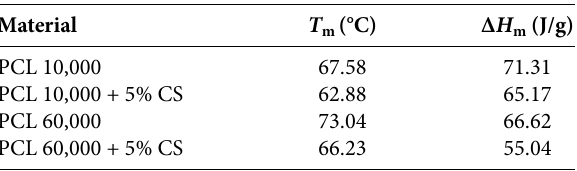
Table 1. Melting temperatures and specific melting enthalpies of the samples. Material